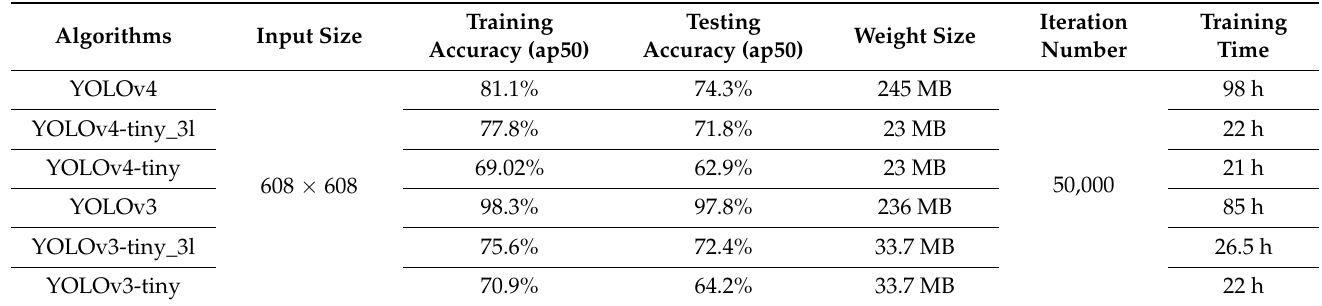
Table 5. Making pretrained weights using YOLOv3.